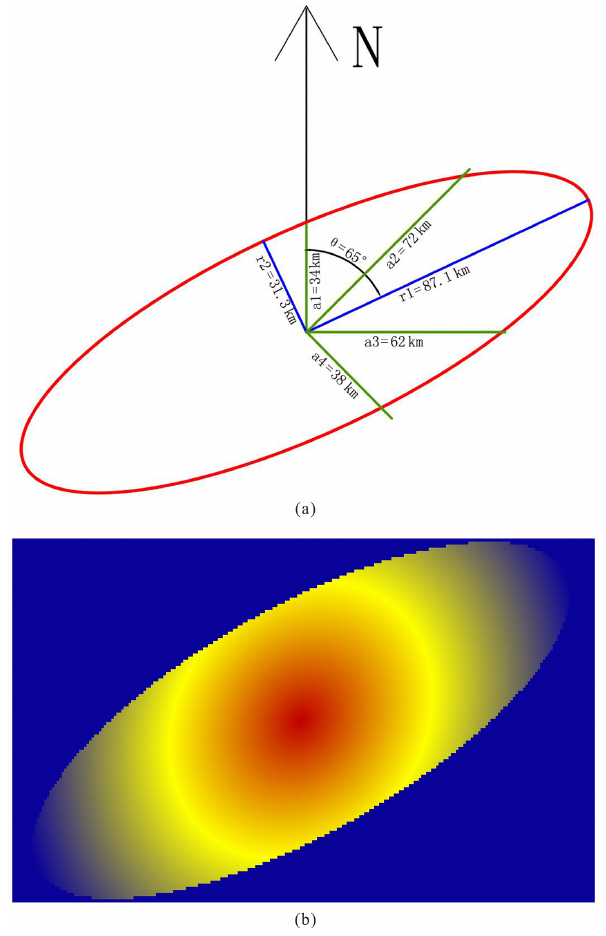
Figure 8. Nested spherical model for different directions. The green lines in (a) correspond to those in Fig. 5, and (b) shows the geo- graphical weight template determined based on (a) .